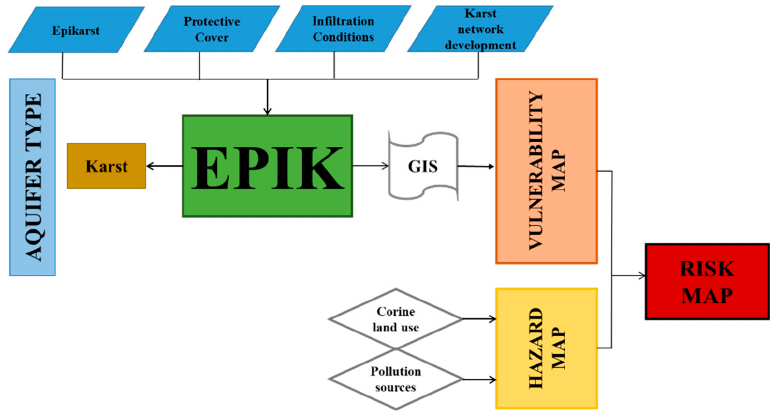
Figure 4. Flowchart of the used processes for generating the vulnerability and pollution risk maps.